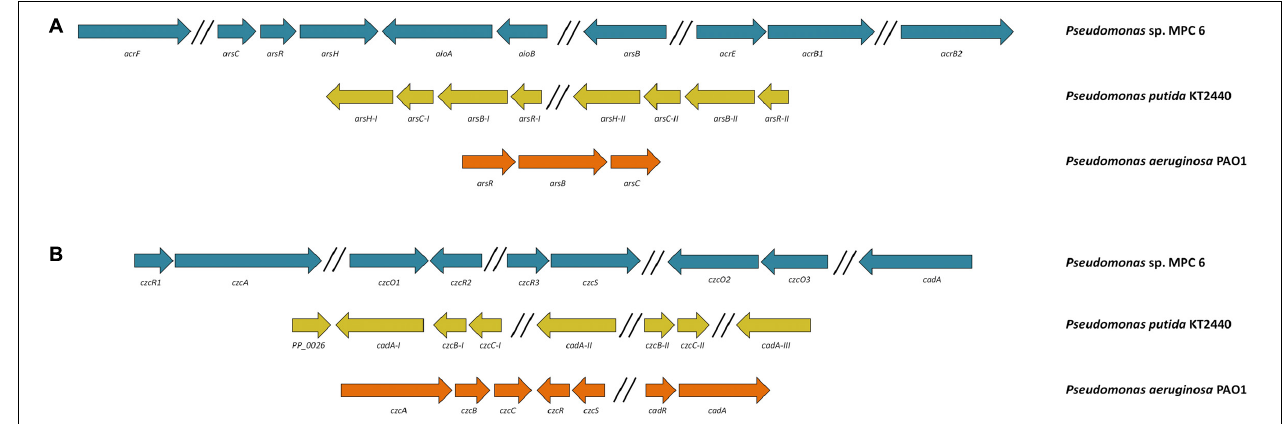
FIGURE 7 | Genetic organization of (A) arsenic and (B) cadmium resistance genes of the Antarctic Pseudomonas sp. MPC6, KT2440, and